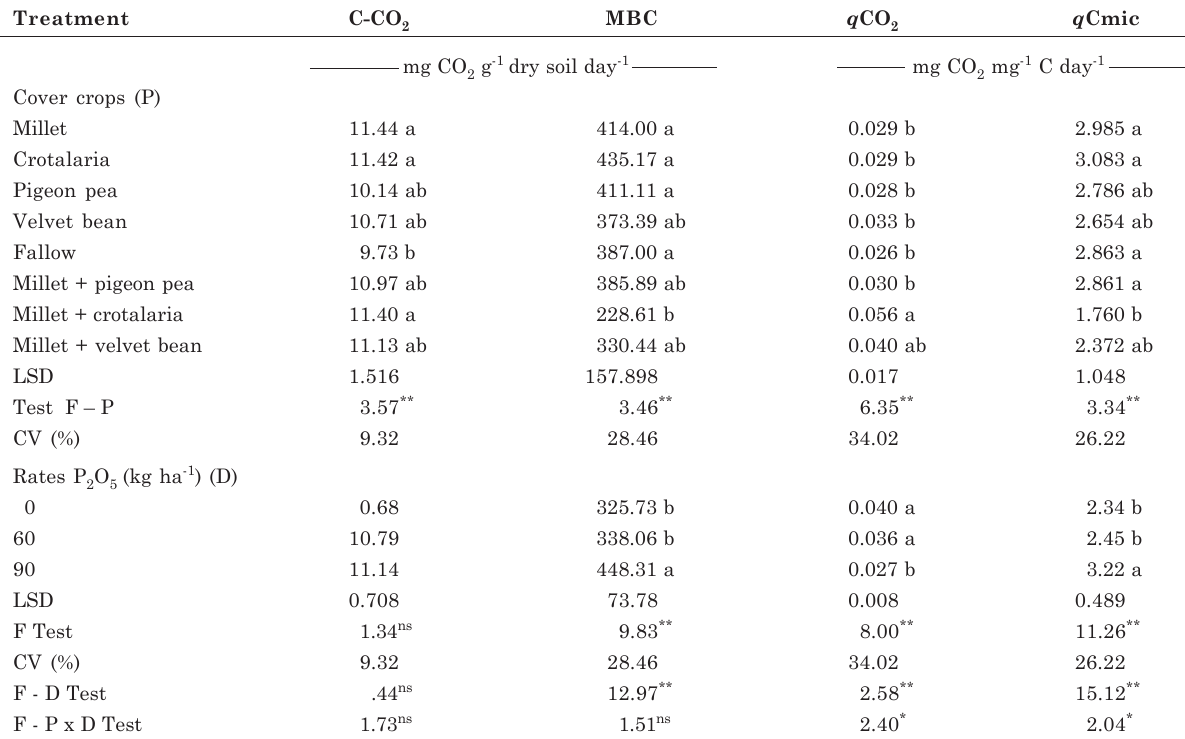
Table 4. Microbial activity (released CO 2 -C), microbial biomass carbon (MBC), metabolic quotient ( q CO 2 ), microbial quotient ( q Cmic), evaluated in the 0-0.10 m layer, according to cover crops and rates of P 2 O